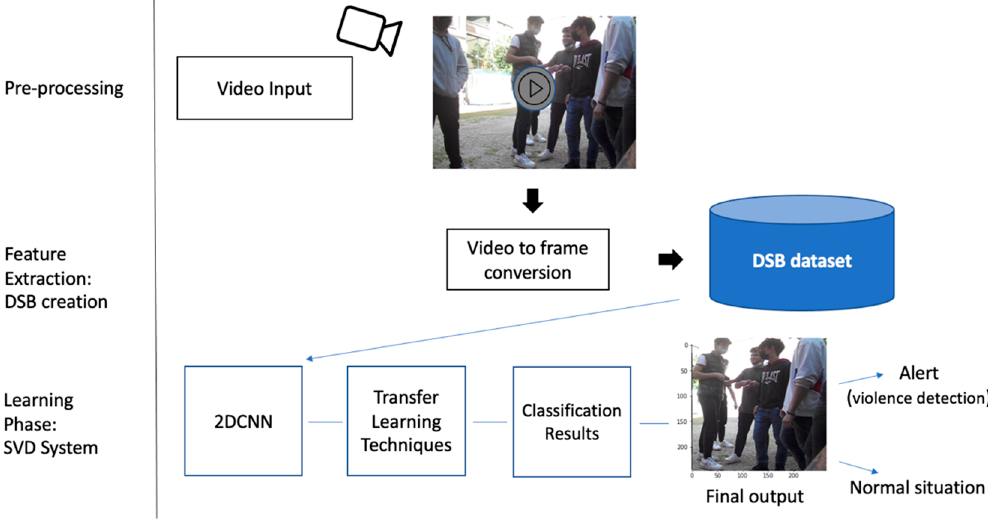
Figure 5. Logical architecture of School Violence Detection (SVD) system.